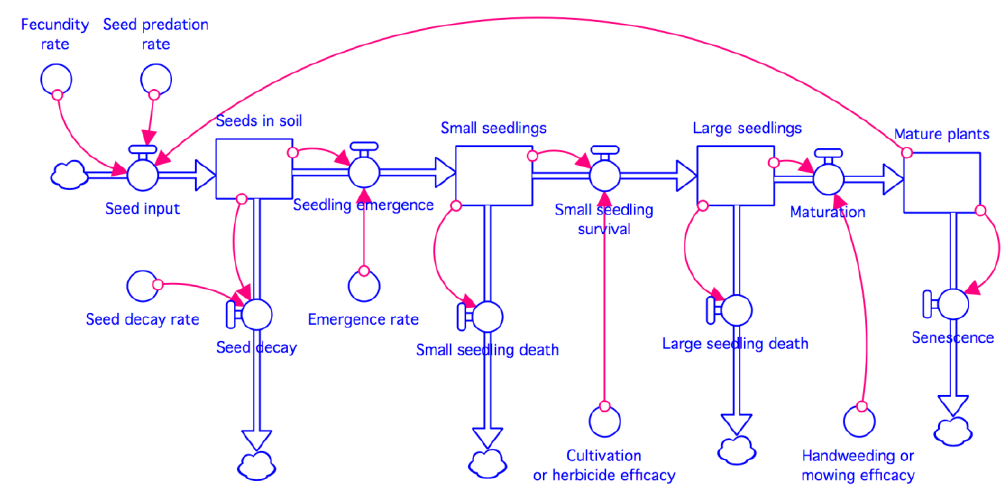
Figure 2. General model for evaluating giant ragweed population dynamics in 2-, 3-, 4-, 5-, and 6-year rotation systems. Details of models for specific rotations are provided in the supplementary materials.